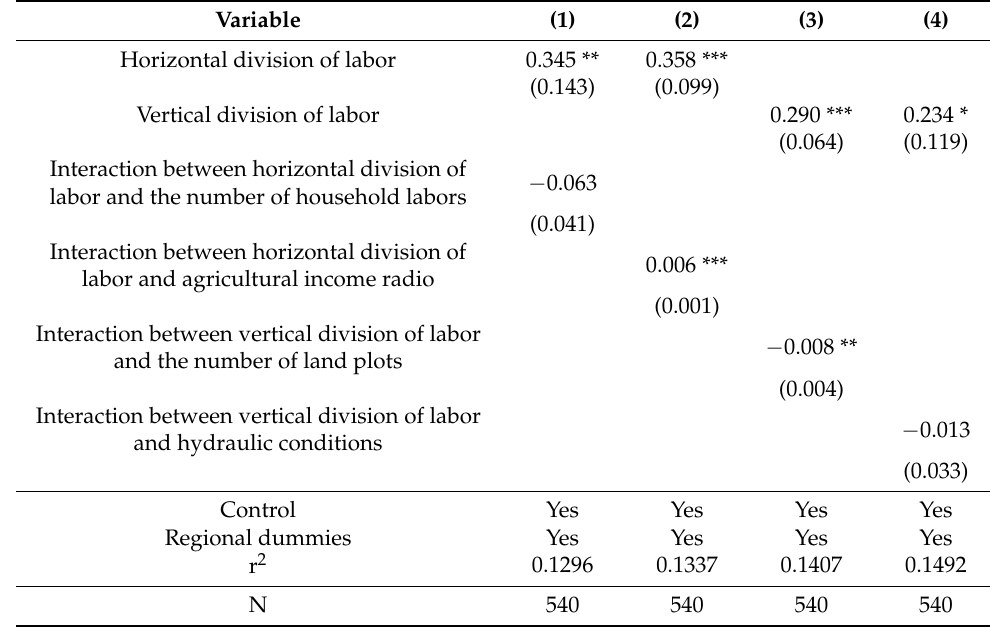
Table 7. Moderating effects of the agricultural division of labor on fertilizer application